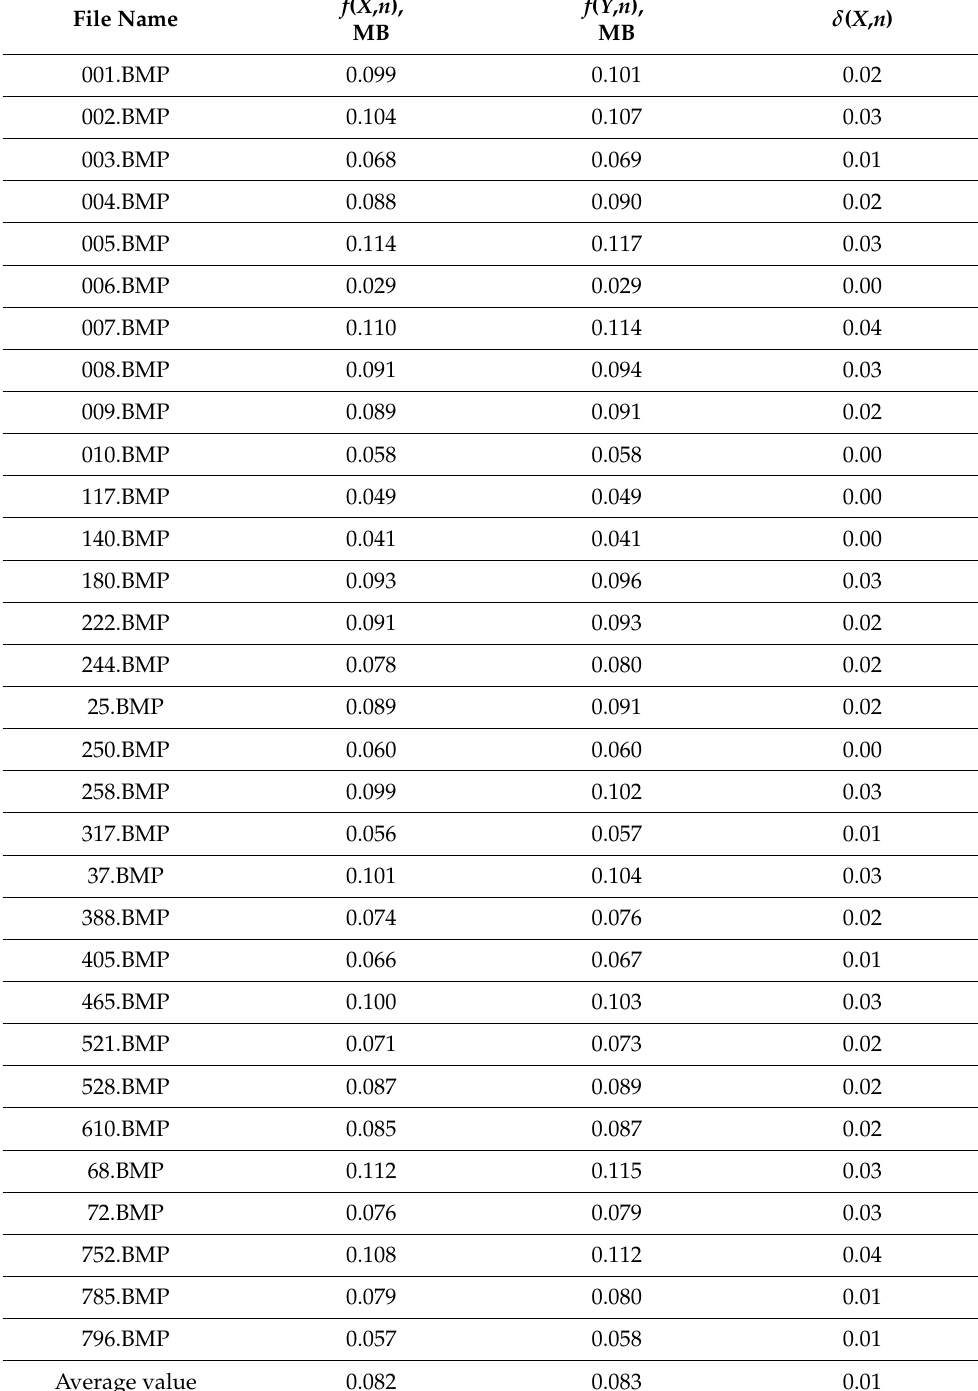
Table 6. Comparison of compression ratio differences for empty and filled containers (by RAR